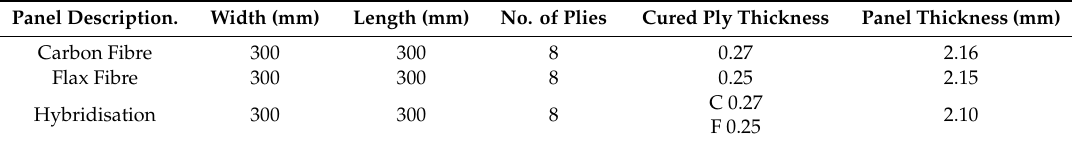
Table 2. Laminate